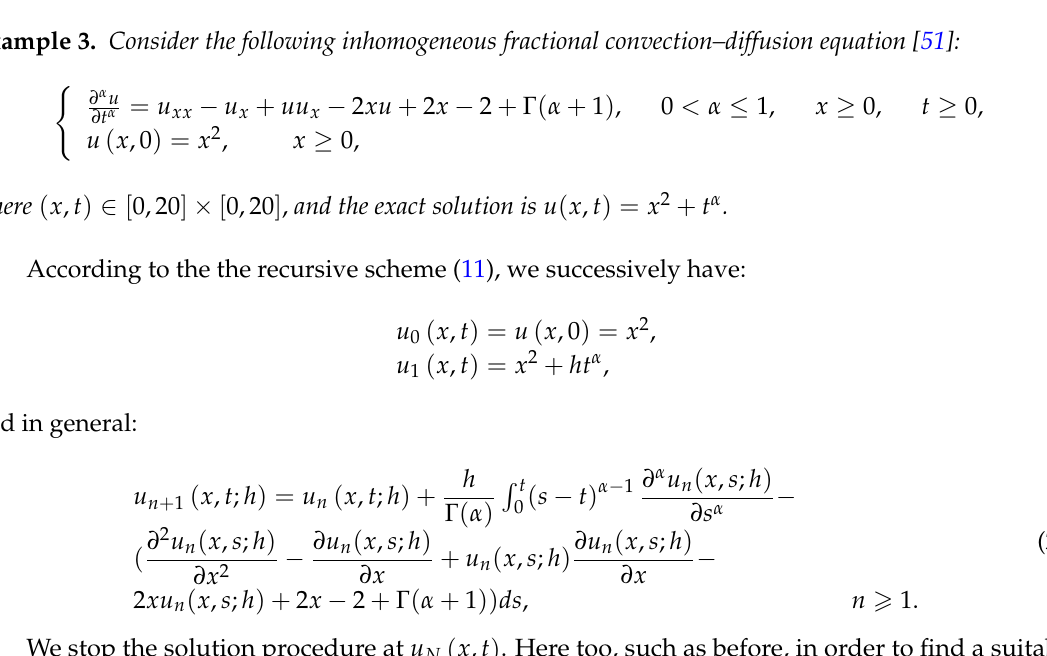
Figure 7. Plots of third-order approximation solutions by present method and standard VIM at x = 10 for α = 0.9 in Example